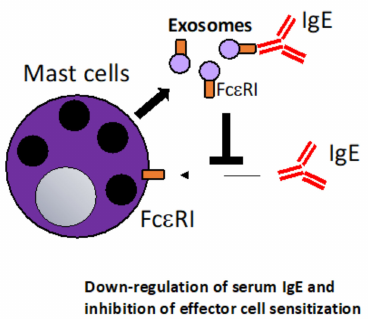
Figure 2. Mast cell (MC)-derived exosomes that neutralize serum IgE. MC release exosomes that express the high-affinity IgE receptor Fc ε RI on the surface. The exosomes can thus act as a “decoy receptor”, negatively regulate binding of IgE to MC surface Fc ε RI. This mechanism could be harnessed in that MC-derived exosomes or exosomes engineered to express Fc ε RI could be used to systemically down-regulate serum IgE levels in allergic patients